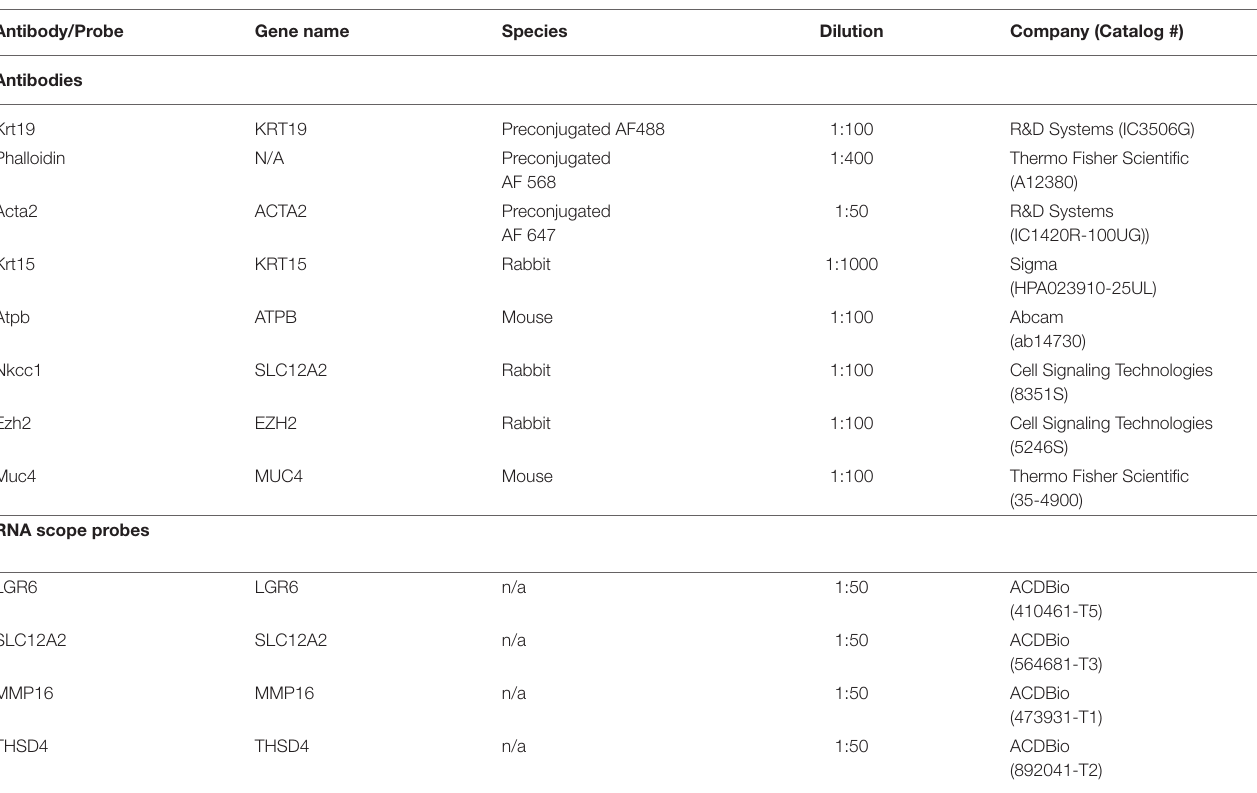
TABLE 1 | Antibodies and probes